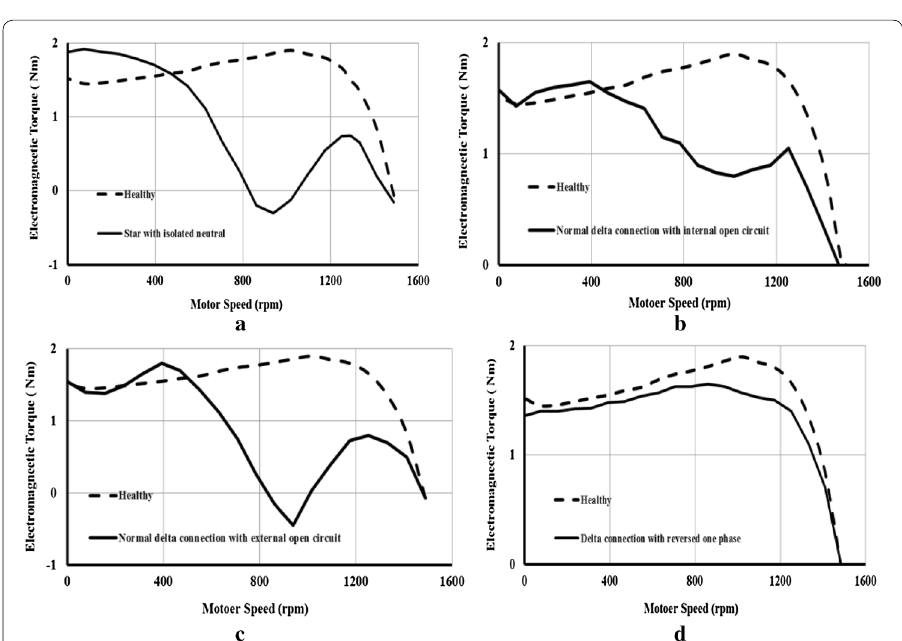
Fig. 11 Experimental results for the torque speed characteristics for, a isolated neutral star connection, b standard delta with internal open circuit, c standard delta with external open circuit and d delta connection with reversed one